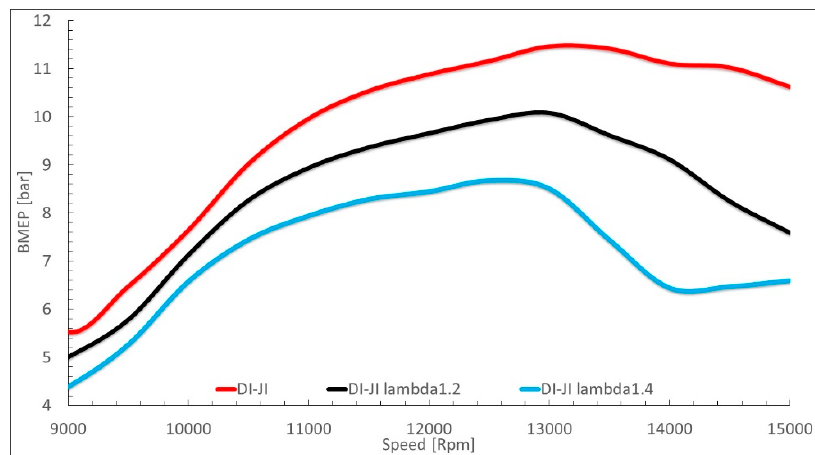
Figure 9. BMEP of stoichiometric and lean burn engines.